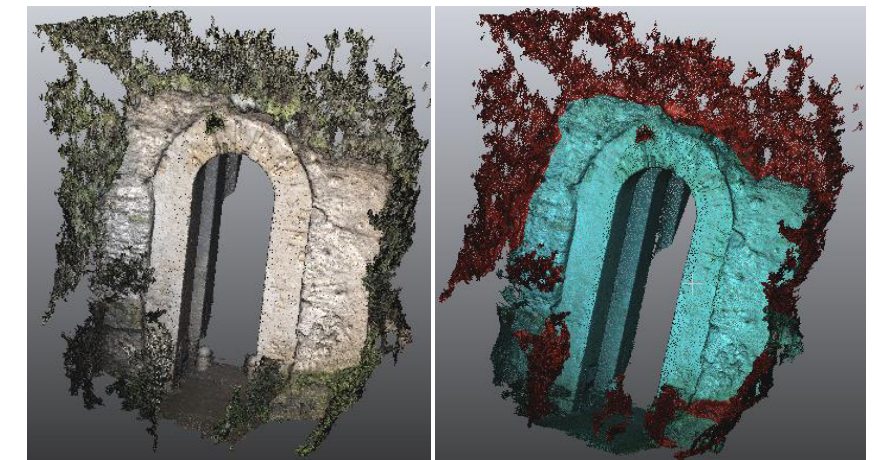
Figure 7: Supervised point cloud segmentation of the Seiano’s Gate point cloud (red: vegetation; light blue: stone).